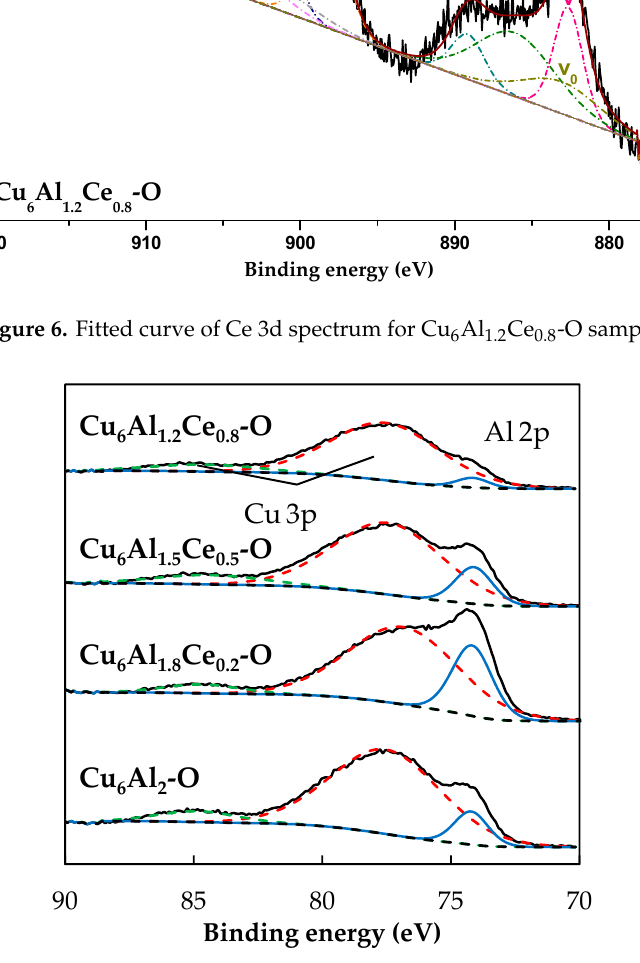
Figure 7. Al 2p photopeaks of Cu 6 Al 2-x Ce x -O samples.